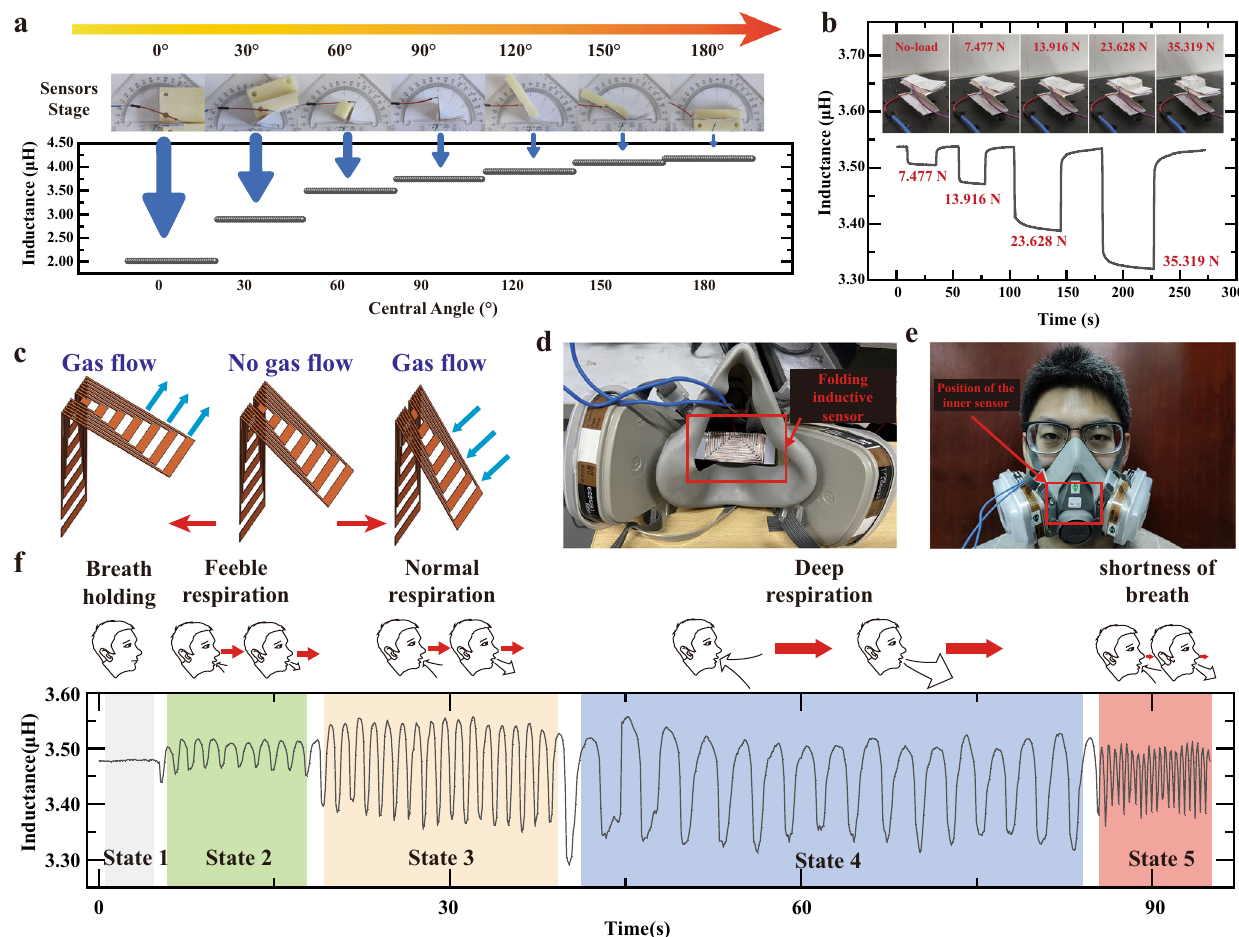
Fig. 7 Various applications of PSIFS. a Measurement results of different angles. b Measurement results of different pressure. c Schematic of the principle of respiratory monitoring. d Position of the sensor in breathing mask. e Pictures of breathing mask and sensor in the practice. f Monitoring results of PSIFS in different breathing